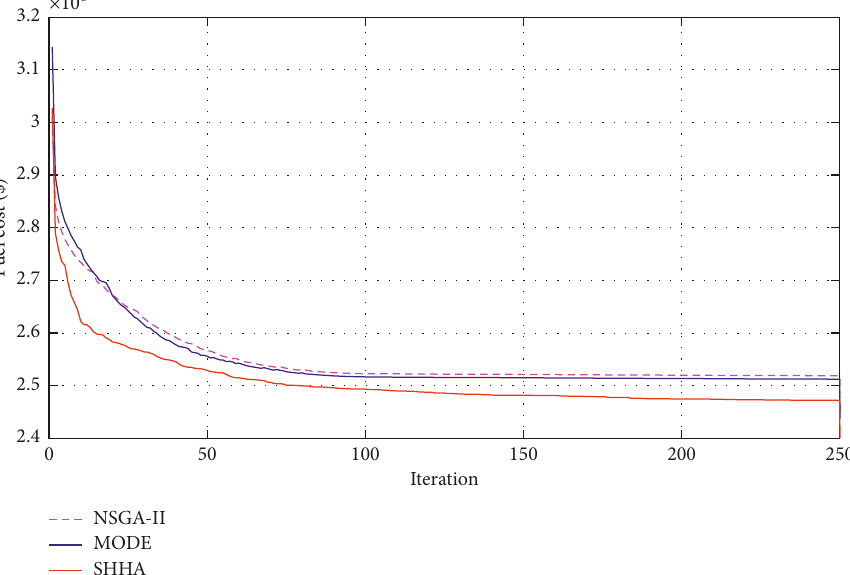
Figure 3: Convergence graphs of NSGA-II, MODE, and